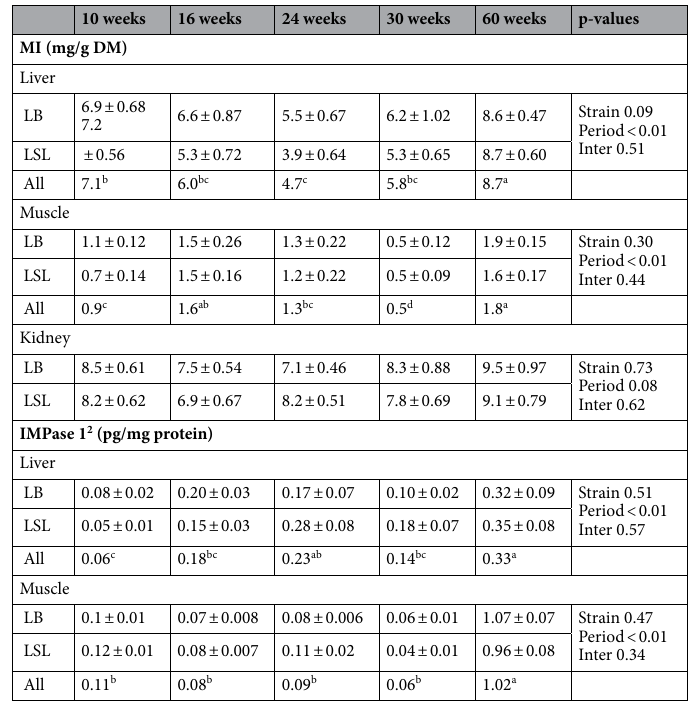
Table 1. MI and IMPase 1 concentration in liver, kidney and muscle of LB and LSL hens in five periods of production. Values for each variable are given as LSmeans ± SEM. MI : myo -inositol, IMPase 1 inositol monophosphatase 1. Different letter indicates statistical differences along productive period of all hens. The number of replicates per strain and period was 10, with the exception of LSL hens at 60 weeks, where it was 9. Interactions between strain and period are indicated by “Inter.” p <